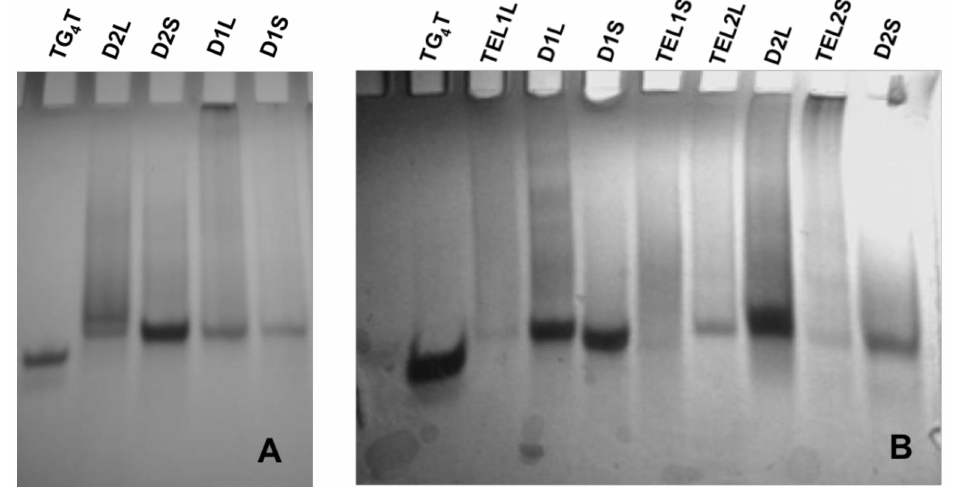
Figure 2. PAGE analyses of complexes formed by DEL-(TG 4 T) 2 ODNs ( D1L,S and D2L,S ) in comparison with the (TG 4 T) 4 G4 ( A ) and with the complexes formed by TEL-(TG 4 T) 4 ODNs ( TEL1L,S and TEL2L,S ) ( B ). All samples were annealed in 100 mM K +